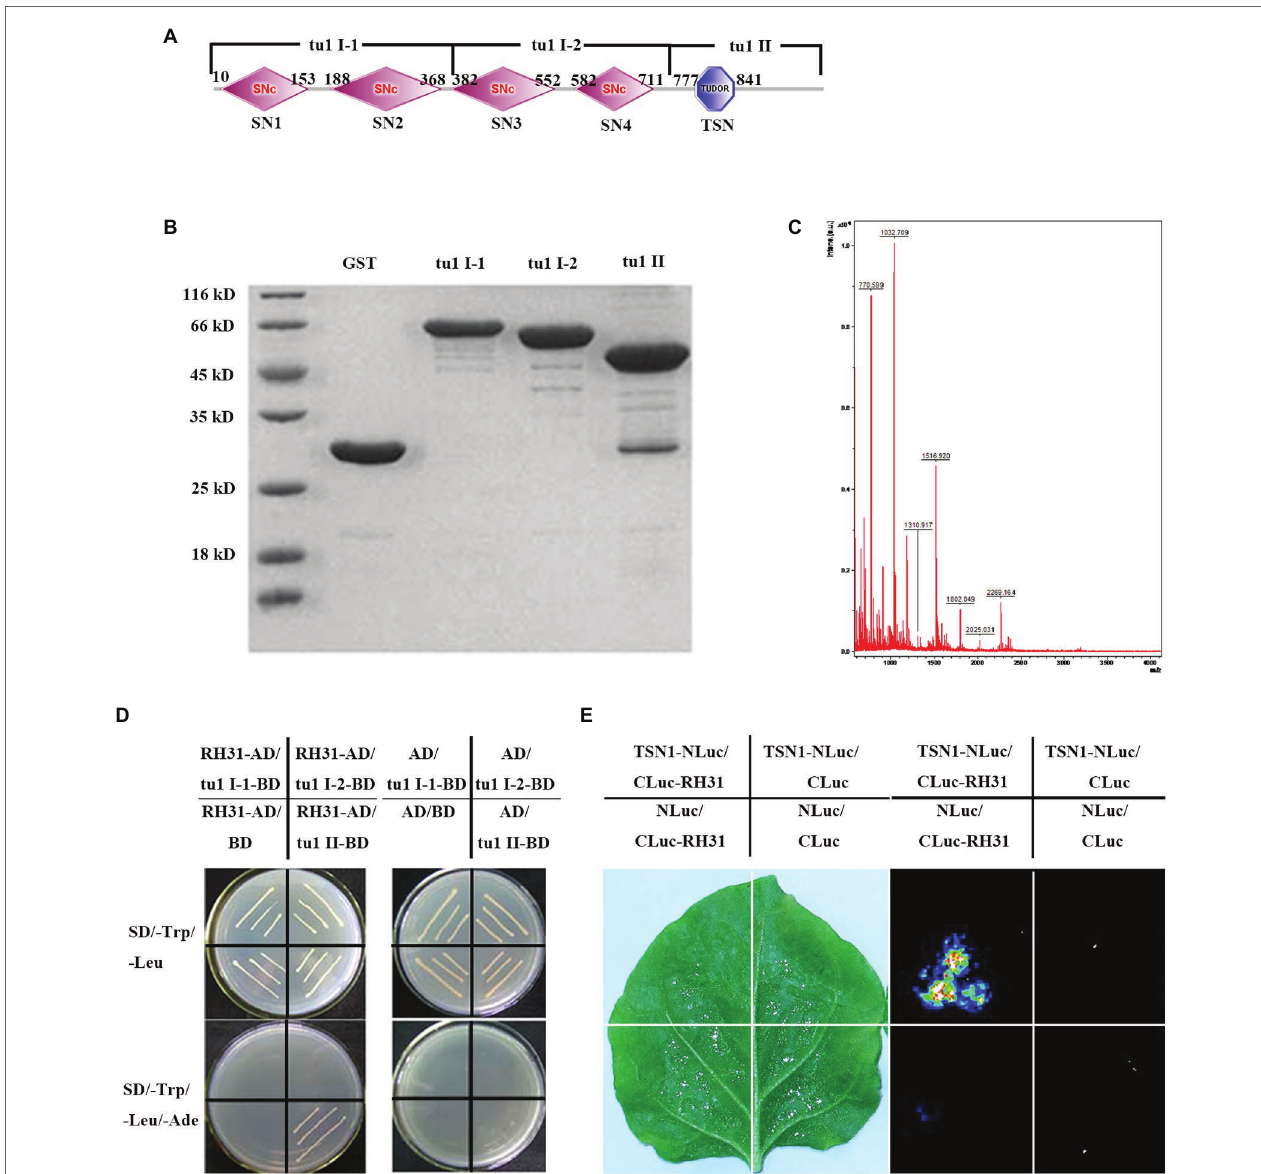
FIGURE 1 | Identification of the RH31-TSN1 interaction. (A) The predicted protein domains of TSN1. The four SNc from left to right represent SN1, SN2, SN3, SN4, respectively. (B) GST Pull-down assay of truncated TSN1 protein. Three TSN1 fragments were generated as follows: tu1 I-1 (1–380 amino acids), including SN1 and SN2 domains; tu1 I-2 (381–720 amino acids), including SN3 and SN4 domains; tu1 II (721–970 amino acids), including C-terminal TSN (Tudor-SN) domain. GST fusion protein was used as bait to pull down the binding proteins of truncated TSN1 protein among total proteins of Arabidopsis seedlings.